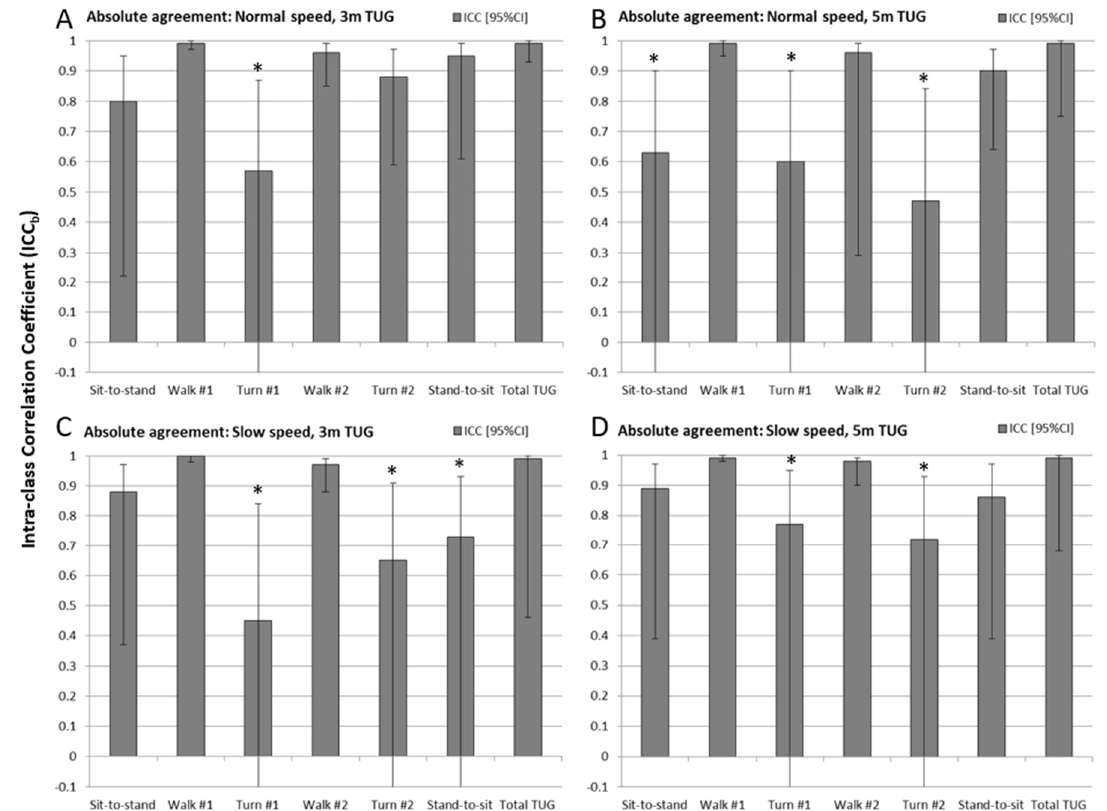
Figure 5. Intraclass correlation between measures (ICC b ) showing the level of absolute agreement and confidence of that agreement level, for each sub-task phase and total timed up and go time, for each of the four experimental conditions: ( A ) 3 m normal speed; ( B ) 5 m normal speed; ( C ) 3 m slow speed, and; ( D ) 5 m slow speed. Whiskers represent the 95% confidence intervals on the ICC and the asterisk indicates sub-tasks where the 95% confidence interval enclosed zero, and was therefore non-significant ( p >